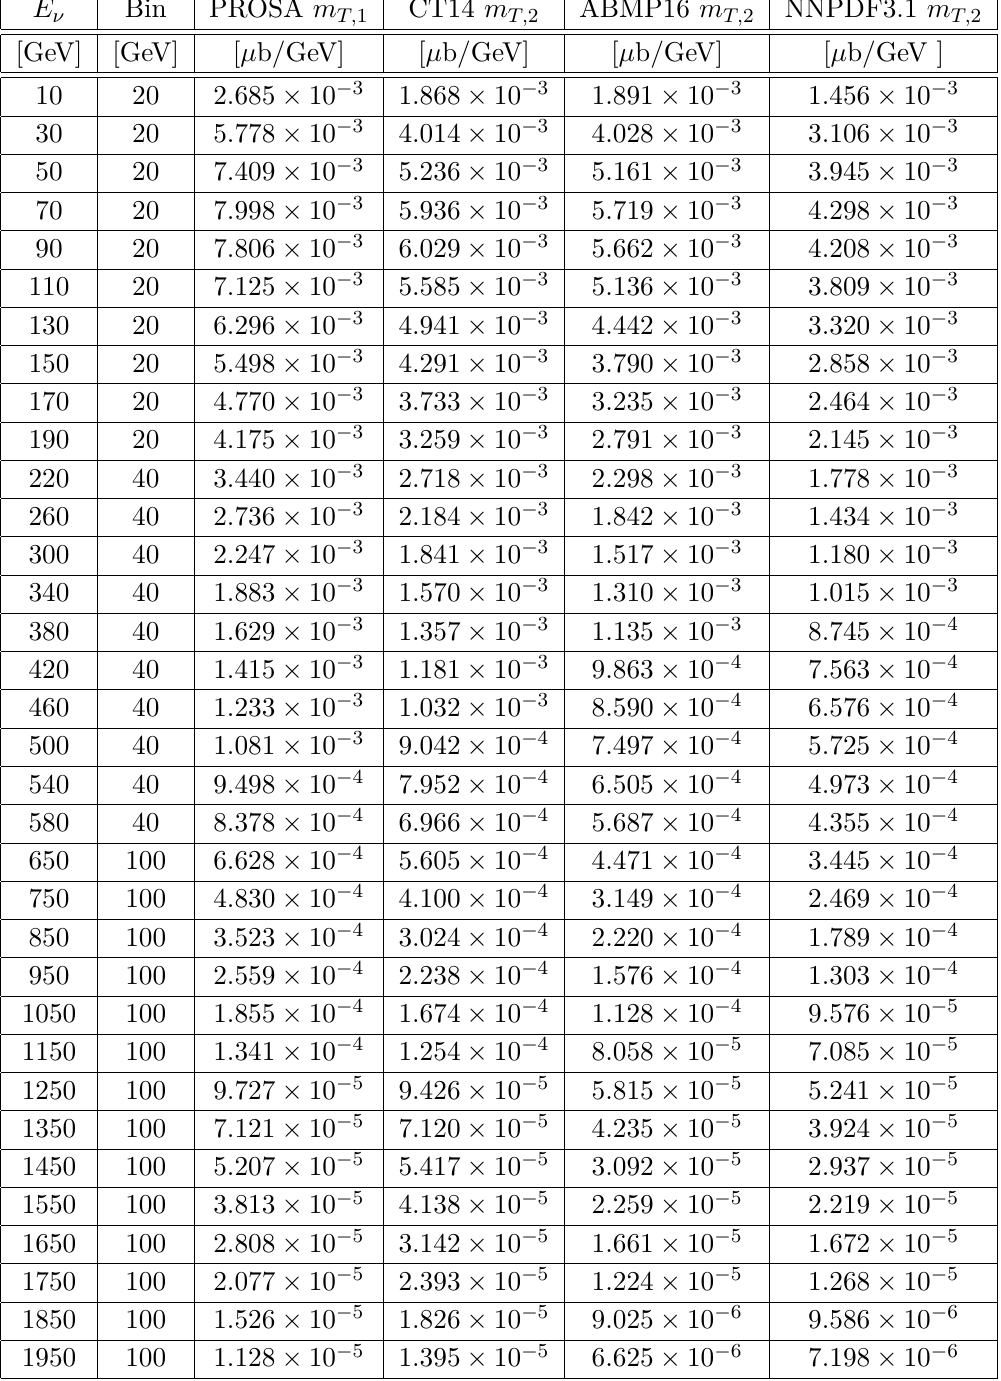
√ for s = 14 TeV, η ν > 6 . 9 . The s